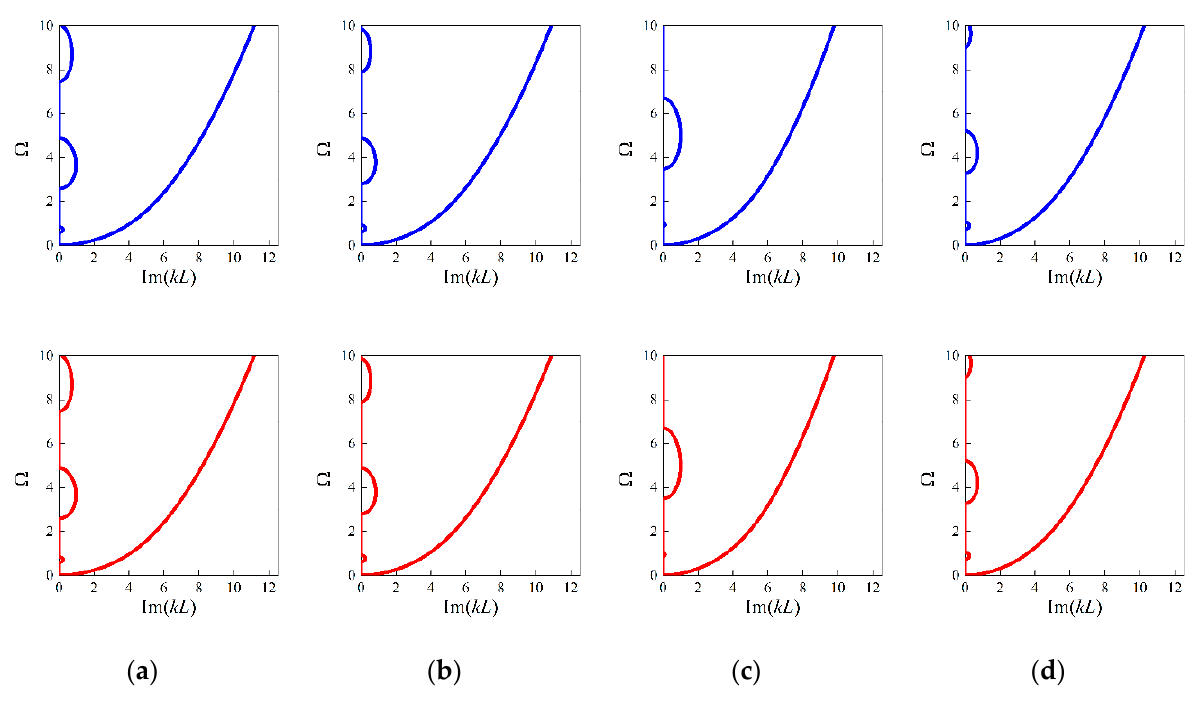
Figure 13. The imaginary panels of flexural waves of the random samples based on the generated structures and real structures with L = 0.0005 m: ( a ) example 1; ( b ) example 2; ( c ) example 3; ( d ) example 4. The blue lines denote the results based on generated values and the red lines denote that of ground truth.